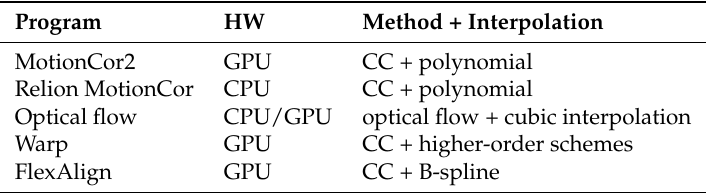
Table 1. Comparison of various movie alignment